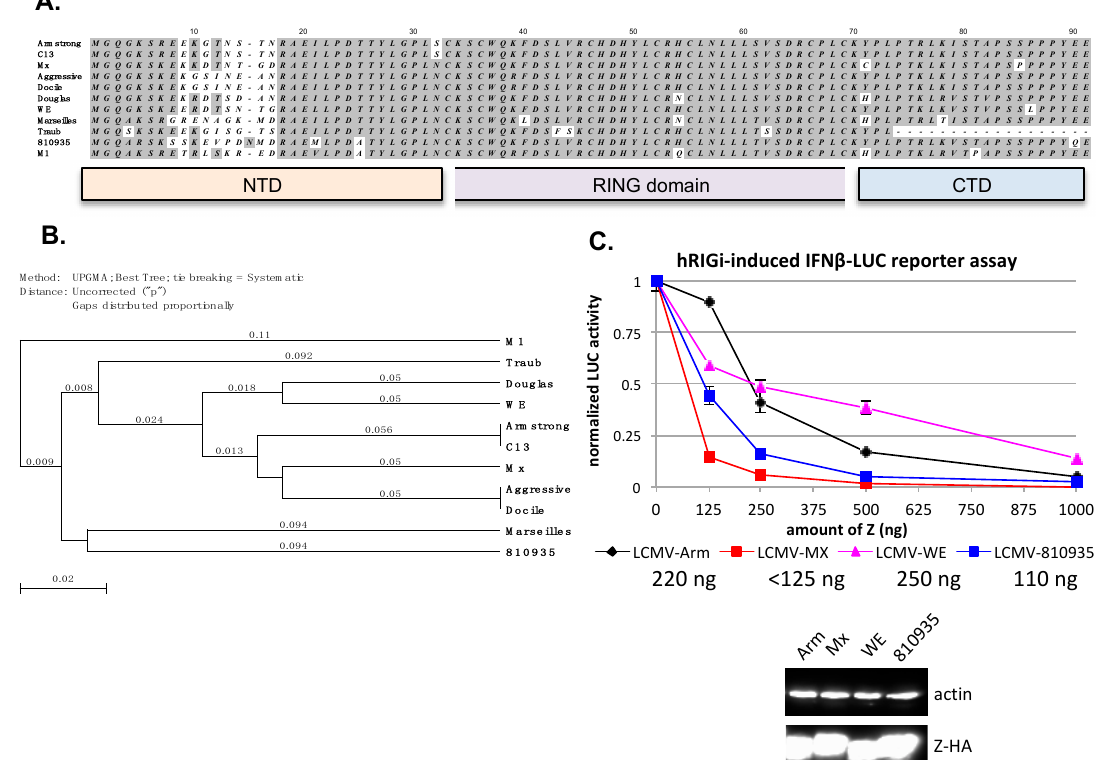
Figure 4. Comparative hRIG-I inhibitory analysis of Z proteins from di ff erent LCMV strains. ( A ) The amino acid sequences of Z proteins from di ff erent LCMV strains, Armstrong (P18541.3), cl13 (ABC96003), Mx (CAA10342), Aggressive (ACA61299), Docile (ACA61303), Douglas (ACV72588), WE, Marseille #12 (ABB88930), Traub (P19325, partial sequence), 810935(ACV72580), and M1 (BAJ52729) were aligned using the MacVector software, with the N-terminal domain (NTD), the central RING domain, and the C-terminal domain (CTD) shown at the bottom. ( B ) The phylogenetic tree based on the amino acid sequences of Z proteins. ( C ) Comparative hRIG-I inhibitory e ff ects by the respective Z proteins (in a dose-dependent manner) of four di ff erent LCMV strains (Armstrong, WE, Mx, and 810935] were determined as described in the legend of Figure 2. Notable di ff erences in the size of the Z proteins correspond to di ff erences in their primary amino acid sequences. The IC 50 values for each of the LCMV Z proteins tested are shown in the figure legend. Western blot analysis of LCMV Z proteins is shown.